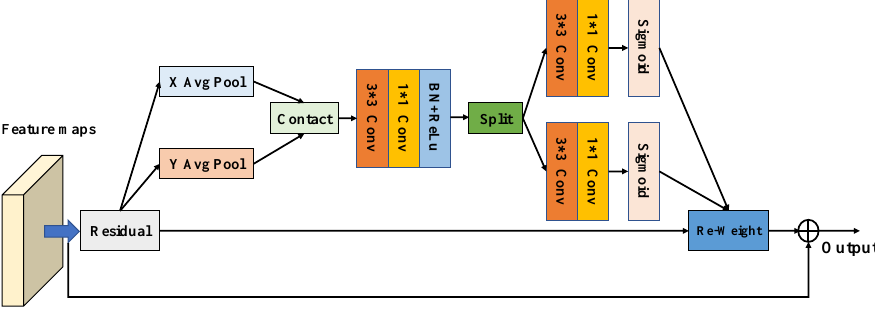
Figure 3. The proposed Coordinate Attention Recalibration